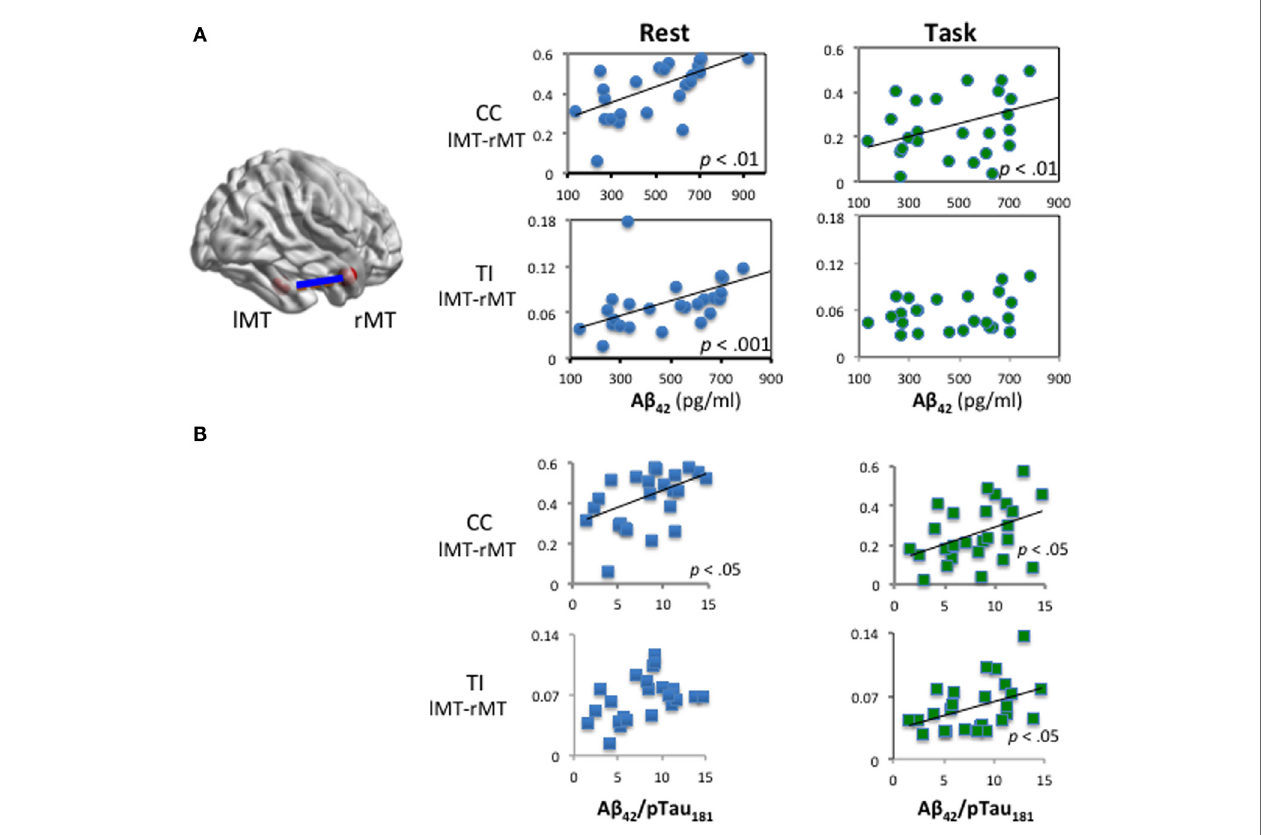
FigUre 2 | Functional connectivity of bilateral temporal gyri and csF a β 42 and a β 42 /pTau 181 . (a) . A β 42 and bilateral anterior MTG connectivity. (B) A β 42 / pTau 181 ratio and bilateral anterior MTG connectivity. Cognitively intact older individuals with increased bilateral MTG were associated with low risk of β -amyloid